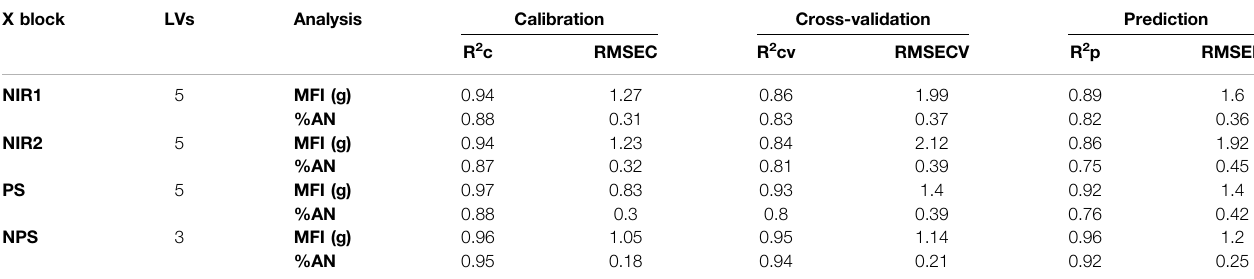
TABLE 1 | Results of PLS